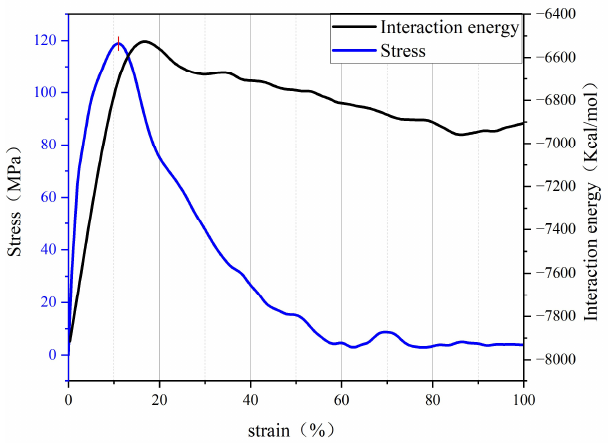
Figure 6. Curves of stress and interaction energy during tensile process.